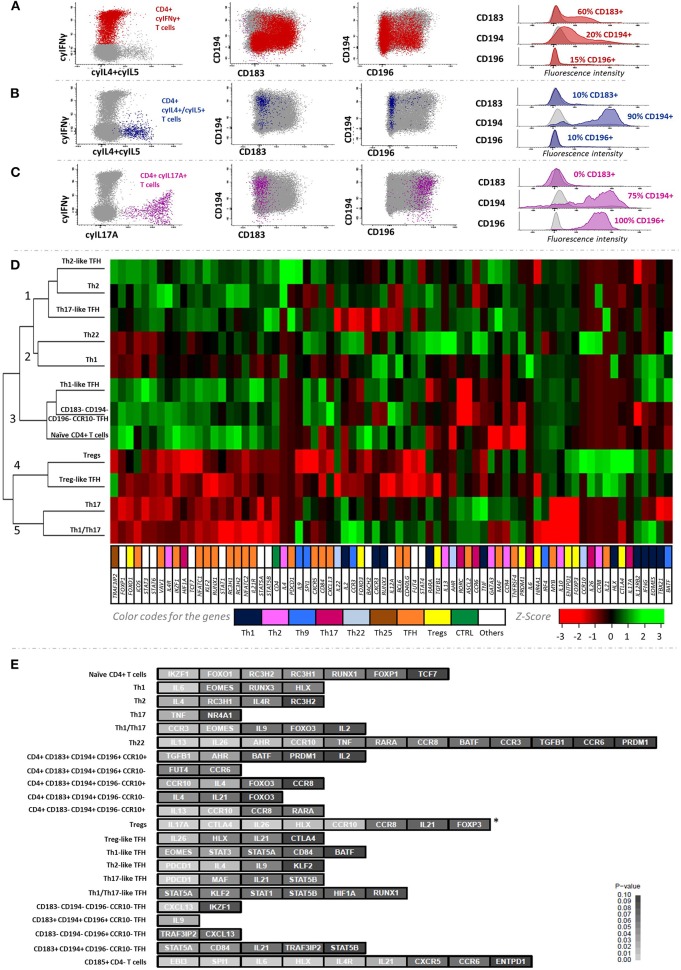
Cytokine secretion profile of the major Th-cell subsets identified in blood and their corresponding gene expression profiles. The association between IFNγ, IL4/IL5, and IL17 production with surface expression of chemokine receptors is depicted in (A–C), respectively. The cluster heatmap in (D) shows the expression levels of each gene normalized as Z-values corresponding to the 12 main CD4+ T-cell subsets sorted. (E) illustrates the discriminatory ability of different groups of genes among the 22 major CD4+ T-cell subsets. Z-test was used to calculate the Z-scores and one-tailed p-values for all genes studied, based on multivariate comparison of their expression among the different CD4+ T-cell subsets (p < 0.05; depicted in light gray). *FOXP3 showed significantly (p = 0.005) higher expression levels in regulatory T-cell subsets (Tregs + Treg-like TFH cells) vs. non-regulatory classical Th cells (Th1 + Th2 + Th17 + Th1/Th17 + Th22).